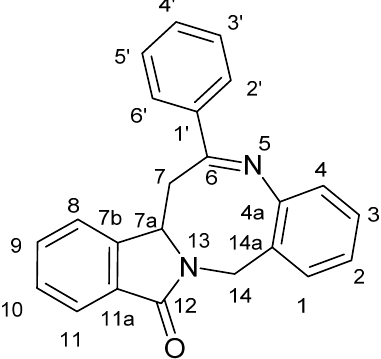
Figure 2. Numbering scheme of 5a for the purpose of NMR assignments. Table 3. Proton NMR assignments of compounds 5a , 5b , 5f and 5h (chemical shift, ppm). [a]